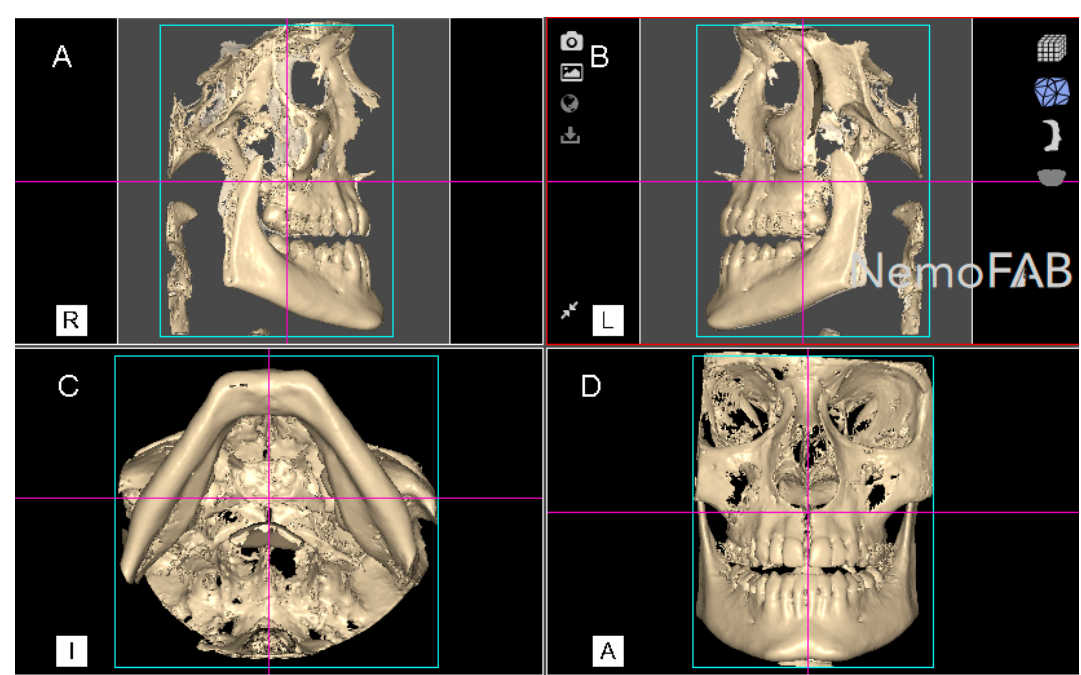
Figure 2. ( A ) Right lateral, ( B ) left lateral, ( C ) bottom and ( D ) frontal view of the postoperative cone-beam computed tomography (CBCT) scans, aligned to the Frankfort plane and the midsagittal plane was perpendicular to the ground.